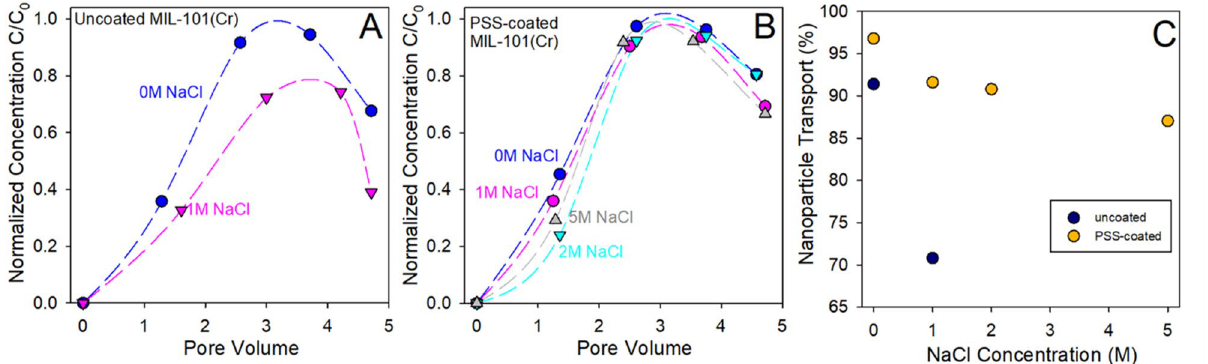
Figure 4. ( A ) Transport of uncoated nanoparticles (NP) in water and 1 M NaCl. ( B ) Transport of polymer- coated MOF nanoparticles (NP-PSS-70K) in water, 1, 2, and 5 M NaCl. ( C ) Comparison of nanoparticle transport for different salinity and particle